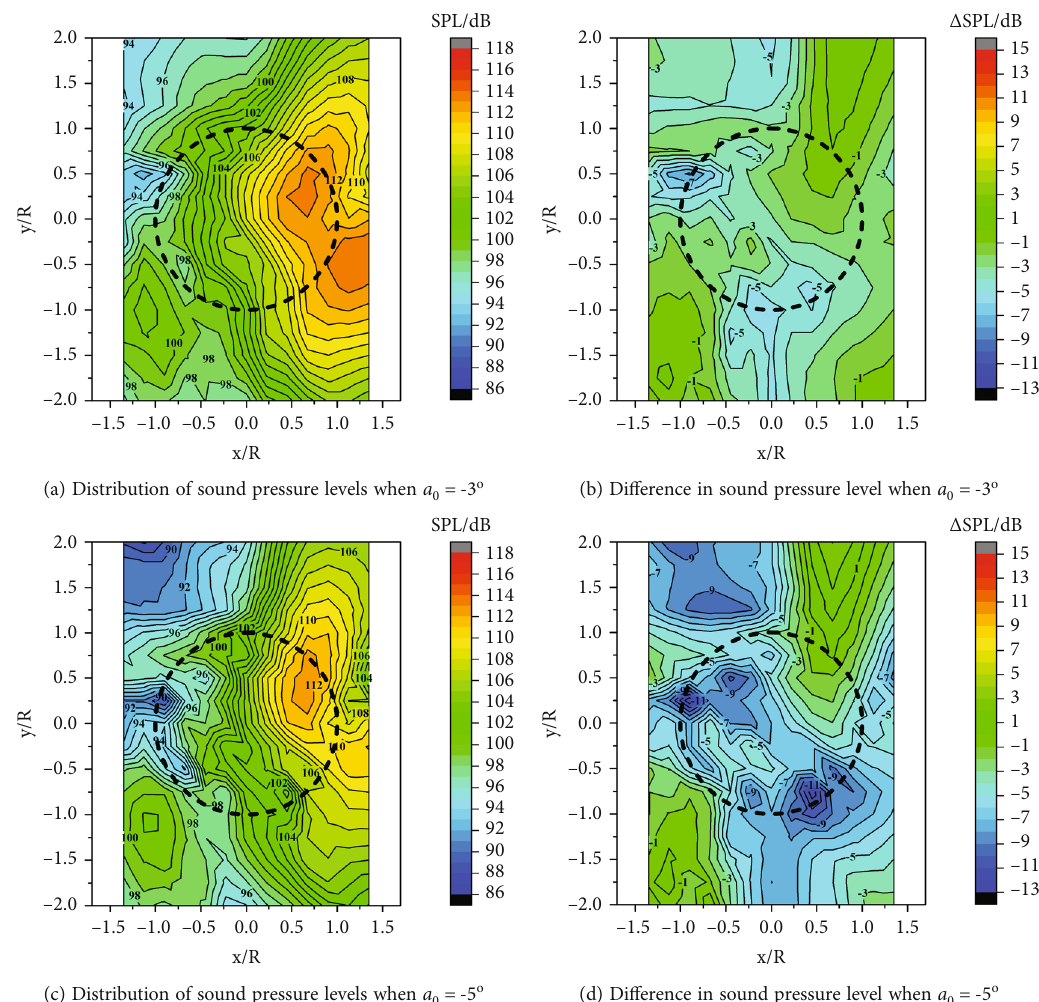
Figure 11: Distribution of SPL below the ECR under Scheme A and their di ff erence from the SPL in the reference